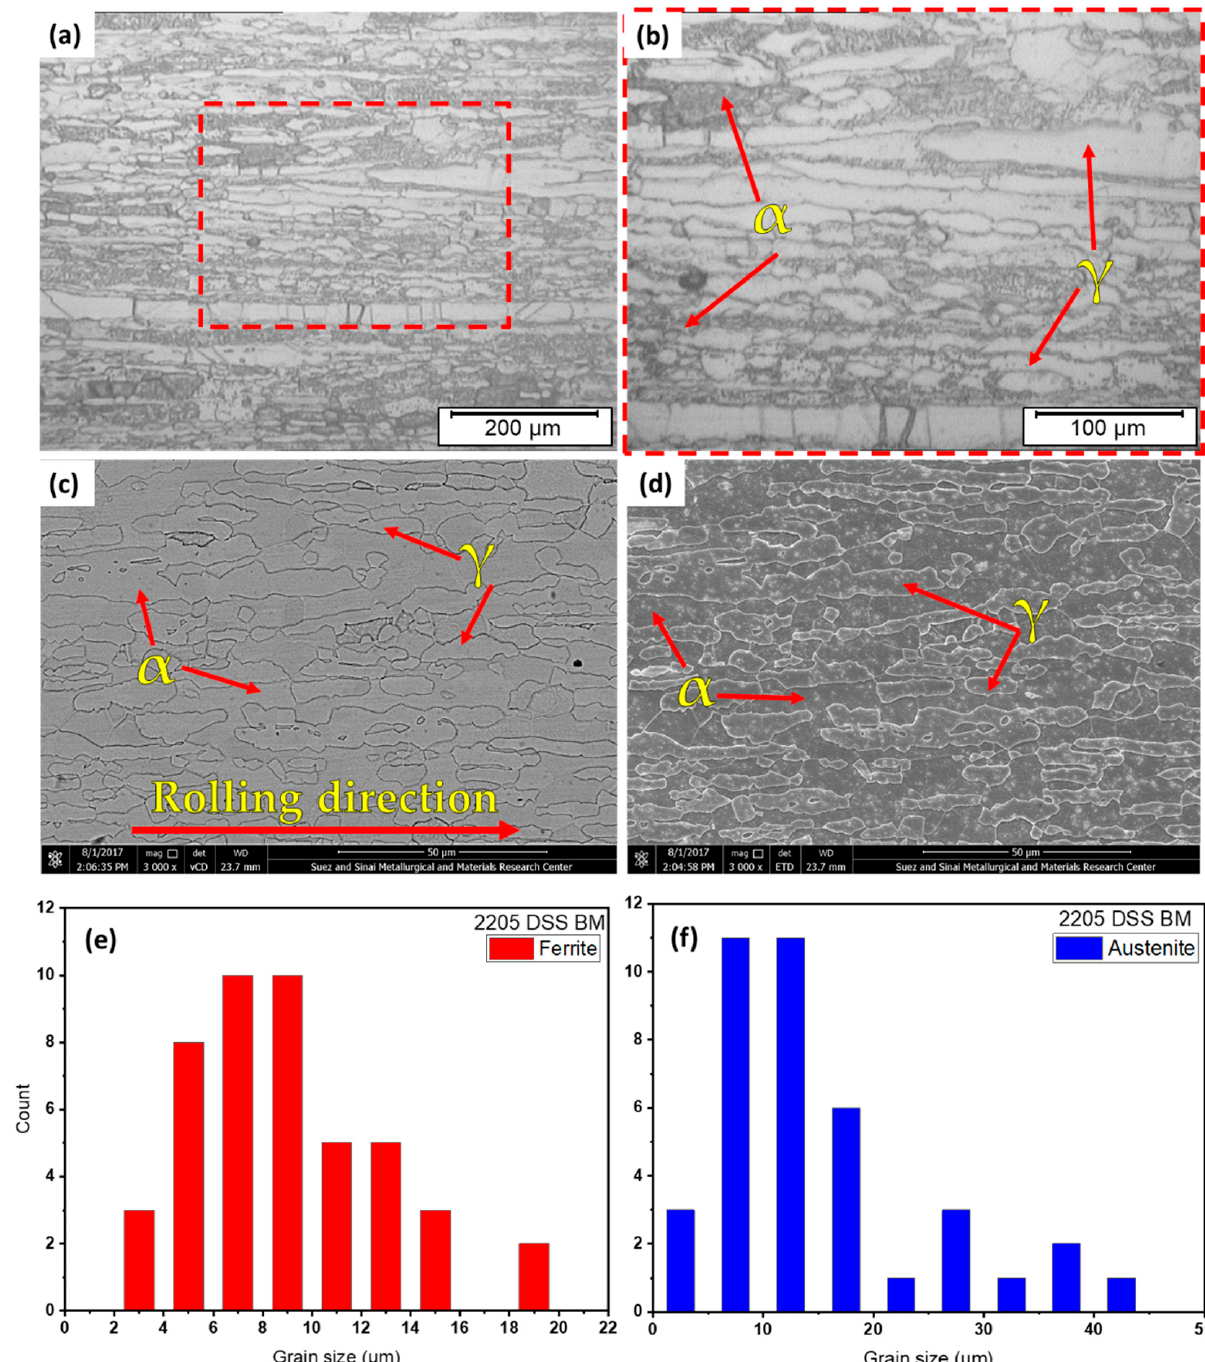
Figure 5. ( a , b ) Different magnifications of optical micrographs of the 2205 DSS BM. SEM images of the BM in two modes are given in ( c ) vCD and ( d ) ETD. ( e , f ) illustrate the BM grain size histograms for both α and γ , respectively. During the FSW process, three distinct zones are formed and surrounded by the